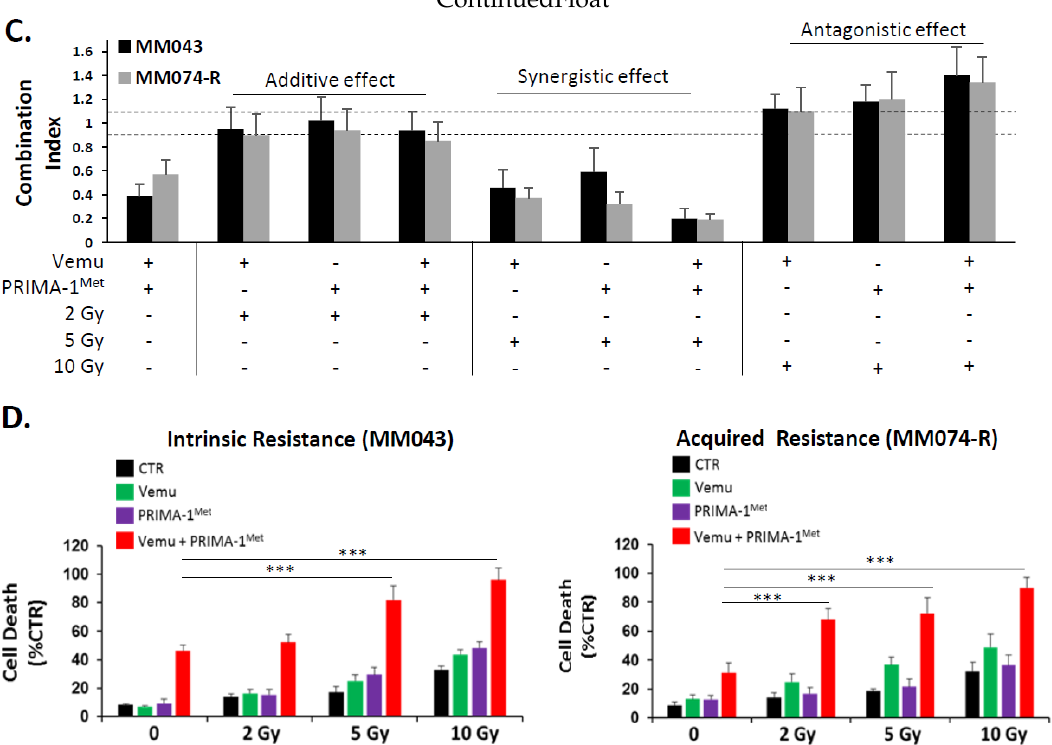
Figure 2. Combining p53 activation and B-Raf proto-oncogene serine / threonine kinase (BRAF) Figure 1. Combining p53 activation and B ‐ Raf proto ‐ oncogene serine/threonine kinase (BRAF) inhibition sensitizes melanoma BRAF mutant melanoma cells to irradiation. ( A ) In the workflow, cells